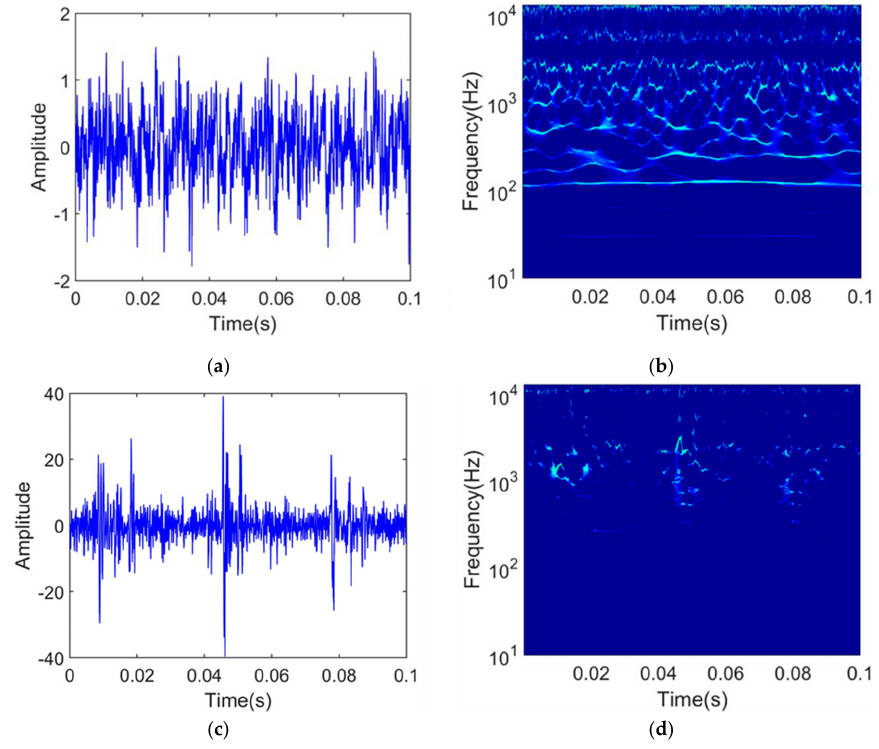
Figure 6. Bearing 1_1: ( a ) Waveform for the first sample; ( b ) time–frequency images for the first sample; ( c ) waveform for the last sample; and ( d ) time–frequency images last sample.